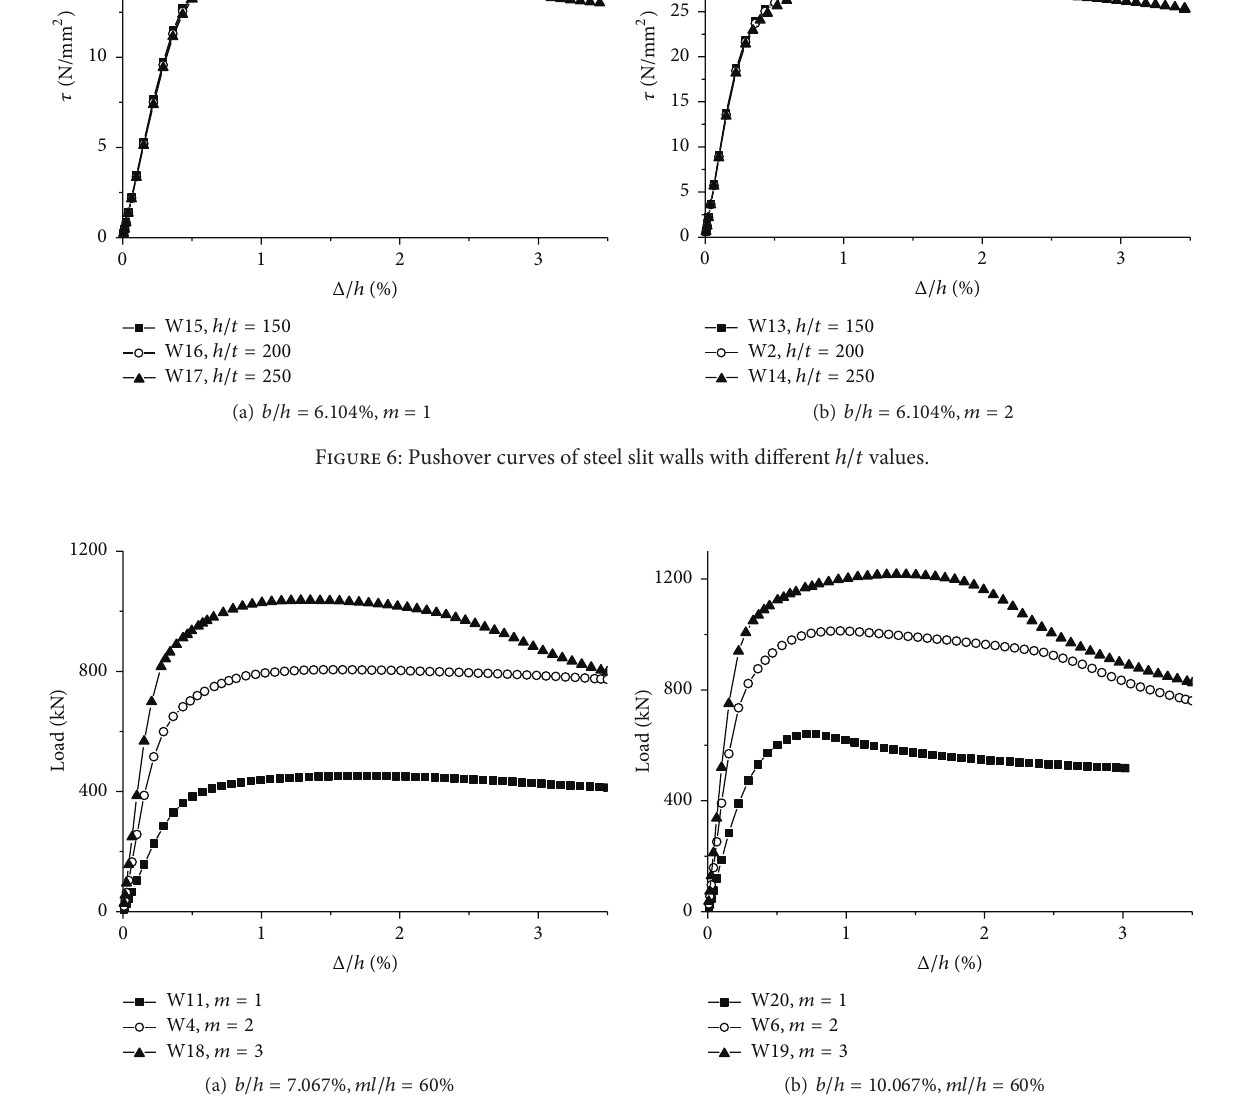
Figure 7: Pushover curves of steel slit walls with different values of 𝑚